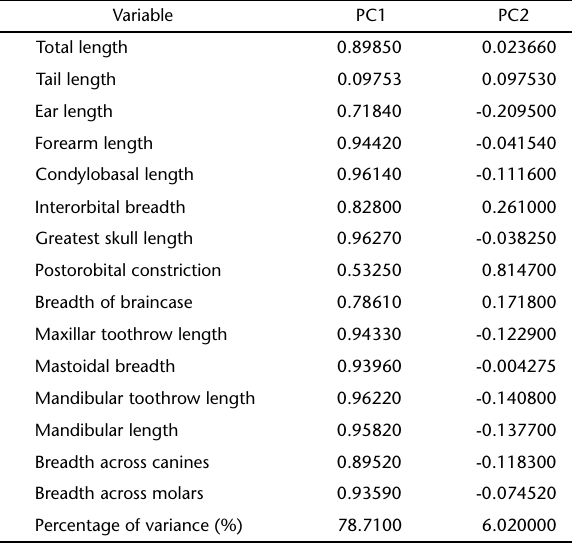
Table II. Loadings of 15 log-transformed morphometric traits and principal components (PC1 and PC2) for Myotis levis levis (males and females) and Myotis levis dinellii